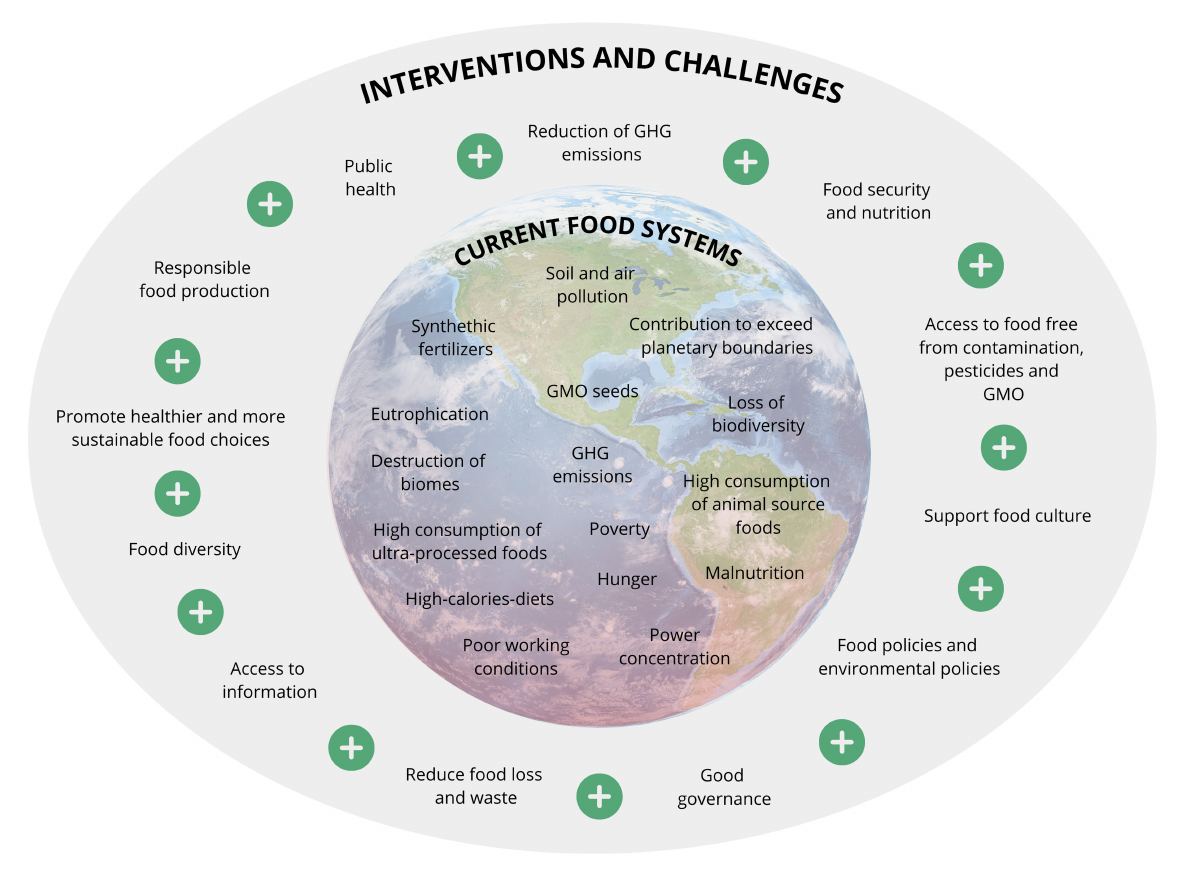
FIGURE2 Scenario of environmental and health consequences of the food system associated with the planetary boundaries (Campbell et al., 2017; Swinburn et al., 2019; Willett et al., 2019).